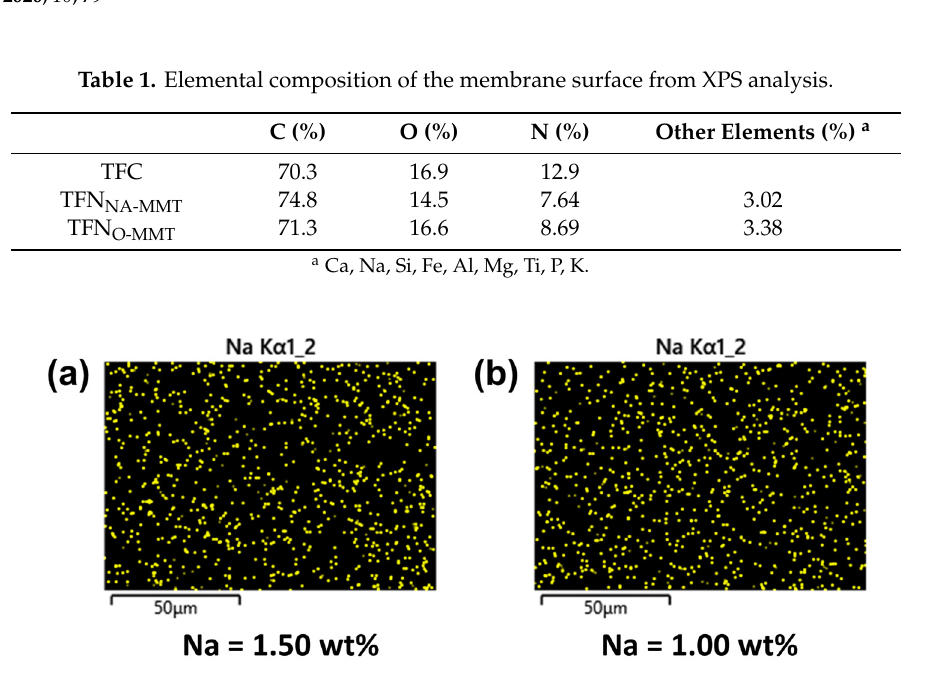
Figure 5. EDX mapping of Na element: ( a ) TFN Na-MMT ; ( b ) TFN O-MMT . Particle concentration = 0.05 g O-MMT / g trimesoyl chloride (TMC).